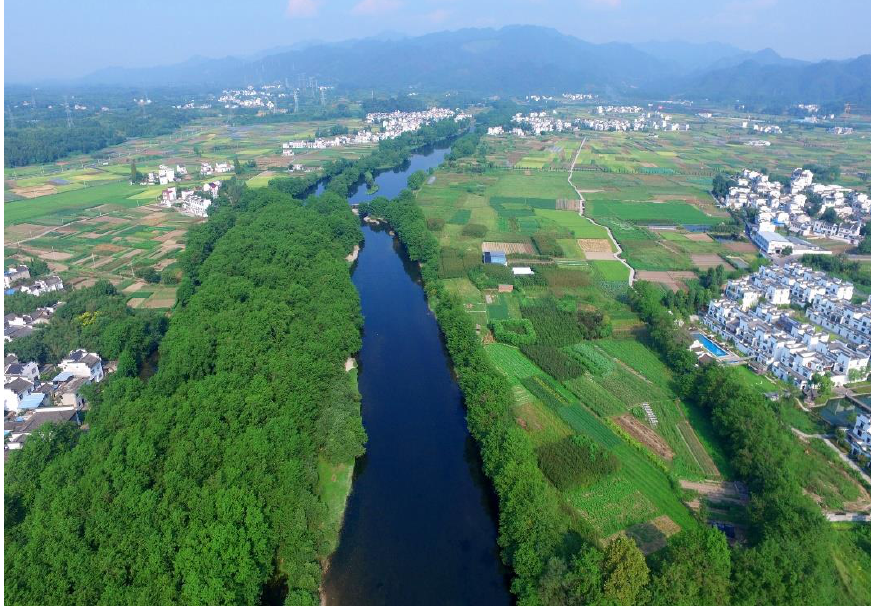
Figure 3. The ecological environment of Xixinan. Source: the Xixinan township government.